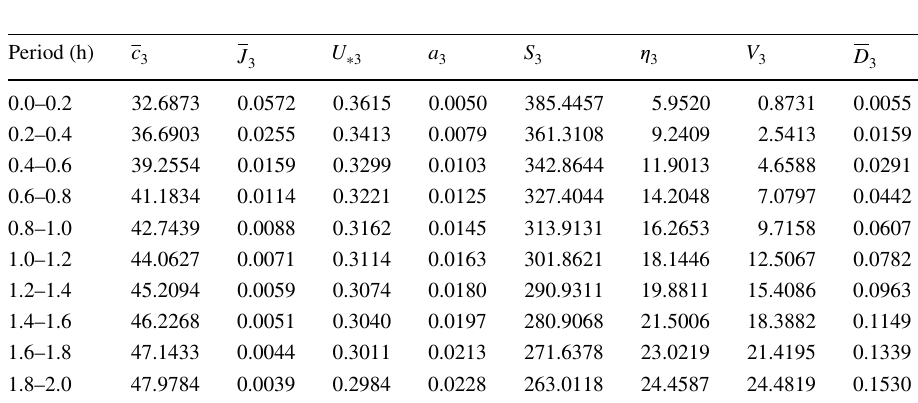
sediment settling rates and average siltation thickness values of the third calculation